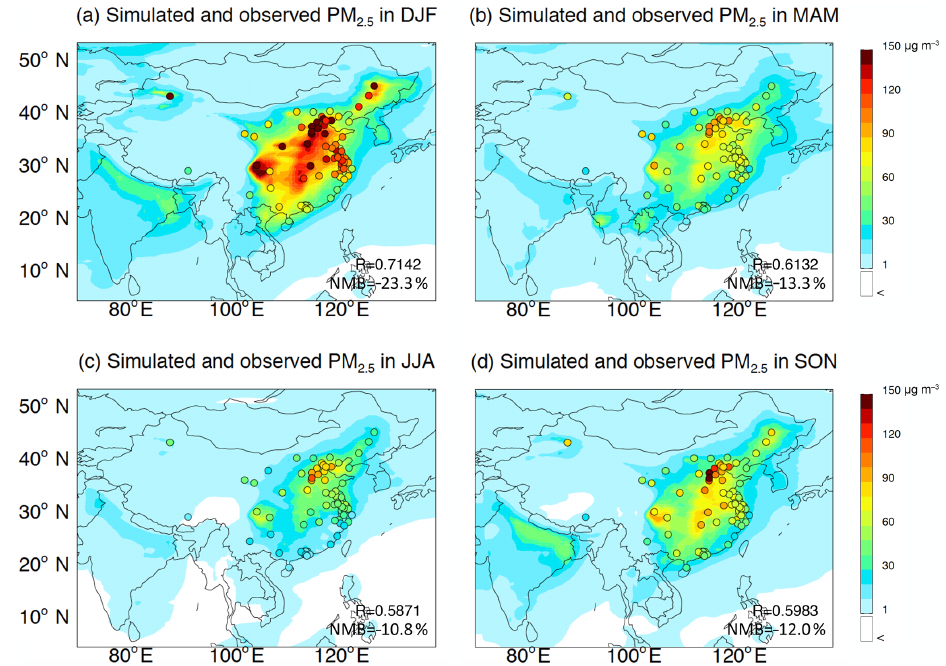
Figure 2. Simulated and observed seasonal PM 2 . 5 concentration in